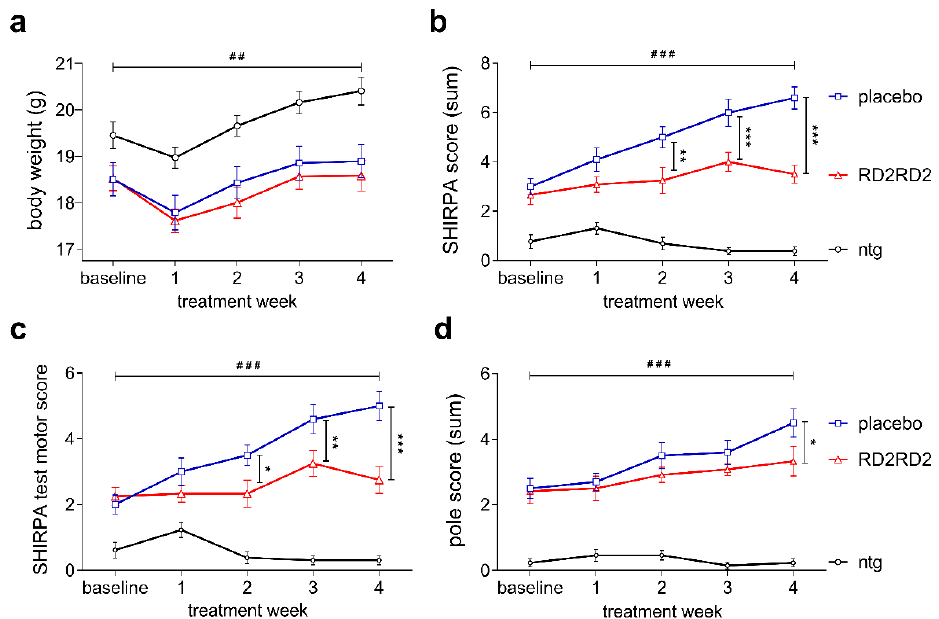
Figure 1. RD2RD2 treatment prevented further significant progression of motor phenotype in SOD1*G93A mice. Changes in absolute body weight (g) over time during treatment revealed significant differences between transgenic and non-transgenic mice ( a ). Analysis of the SHIRPA test battery to evaluate the phenotypic development of RD2RD2- and placebo-treated SOD1*G93A mice resulted in halt of phenotype progression upon treatment ( b ). Subdivision of the SHIRPA parameters into a motor score revealed significant inhibition of motor symptom progression in RD2RD2- vs. placebo-treated SOD1*G93A ( c ). Pole test analysis ( d ) resulted in significant conservation of motor skills in RD2RD2-treated mice, whereas the motor deficits progressed further in placebo-treated mice. All non-transgenic mice exhibited normal motor function throughout the experimental period. Data is presented as mean ± SEM. Statistical calculations were conducted by two-way RM ANOVA with Fisher’s LSD post hoc analysis, non-transgenic mice (ntg) n = 13, RD2RD2 n = 12 and placebo n = 10 for each test. Lozenges ( # ) and asterisks (*) indicate a significance between treatment groups (ntg vs. RD2RD2 or ntg vs. placebo: ## p < 0.01, ### p < 0.001 and RD2RD2 vs. placebo: * p = 0.05, ** p < 0.01, *** p < 0.001).